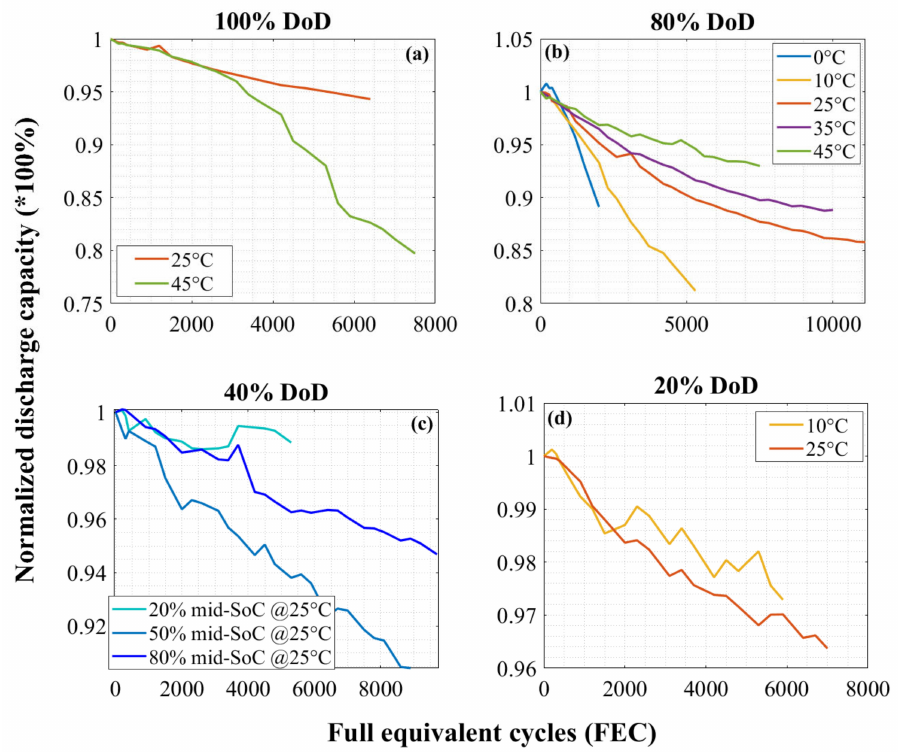
Figure 1. The impact of the cycling conditions on aging: ( a ) full DoD cycling at 2C charge–discharge from moderate to hot temperature, ( b ) high DoD cycling in the 10–90% SoC region with 2C charge–discharge rates at various temperatures, ( c ) medium DoD cycling at various SoC regions with 2C charge–discharge rates at 25 ◦ C, and ( d ) low DoD cycling in the 40–60% SoC region with 2C charge–discharge rates at low and 25 ◦